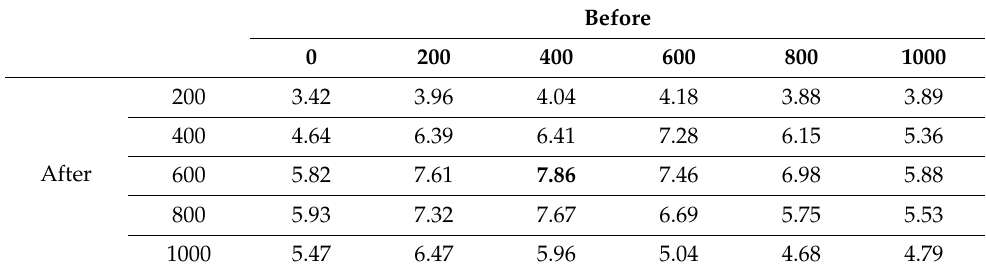
Table 2. The perceived naturalness of Nao. The bold text with a large font means the highest value.